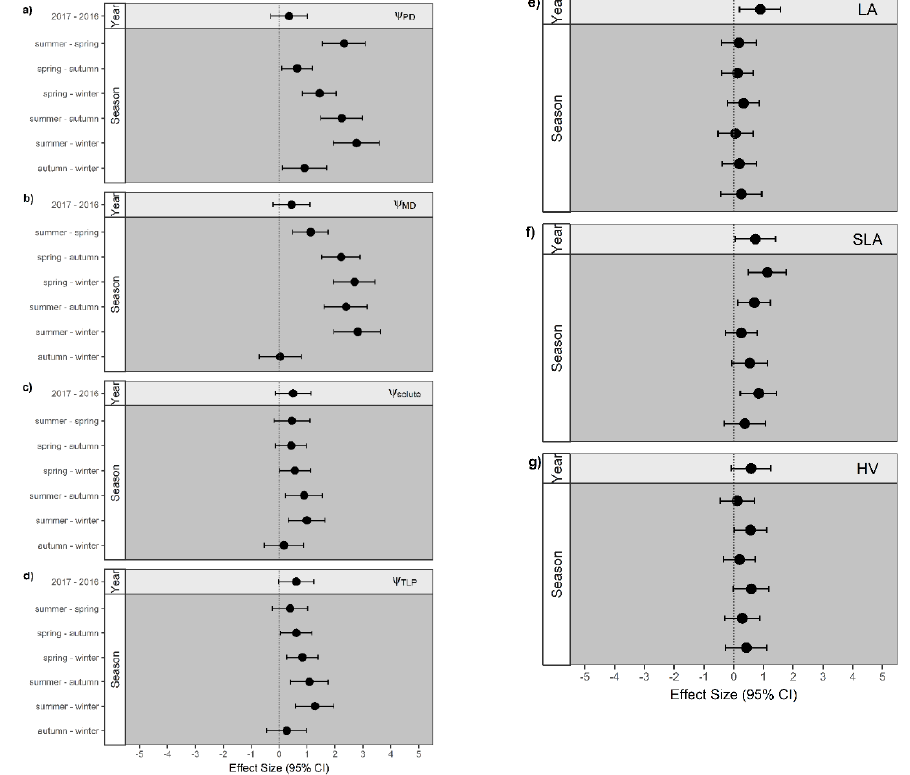
Figure 5. E ff ect size (Hedges’ ( g ) between both complete years (2016 and 2017) and all seasons for: ( a ) Pre-dawn water potential ( Ψ PD ), ( b ) midday water potential ( Ψ MD ), ( c ) solute potential at full turgor ( Ψ solute ), ( d ) water potential at turgor loss point ( Ψ TLP ), ( e ) leaf area (LA), ( f ) specific leaf area (SLA), and ( g ) Huber Value (HV). The trait data were used on tree level, and all 18 trees were used prior to the installation of the throughfall gutters. Following the throughfall gutter installation, we used only data from nine trees (control plot trees).